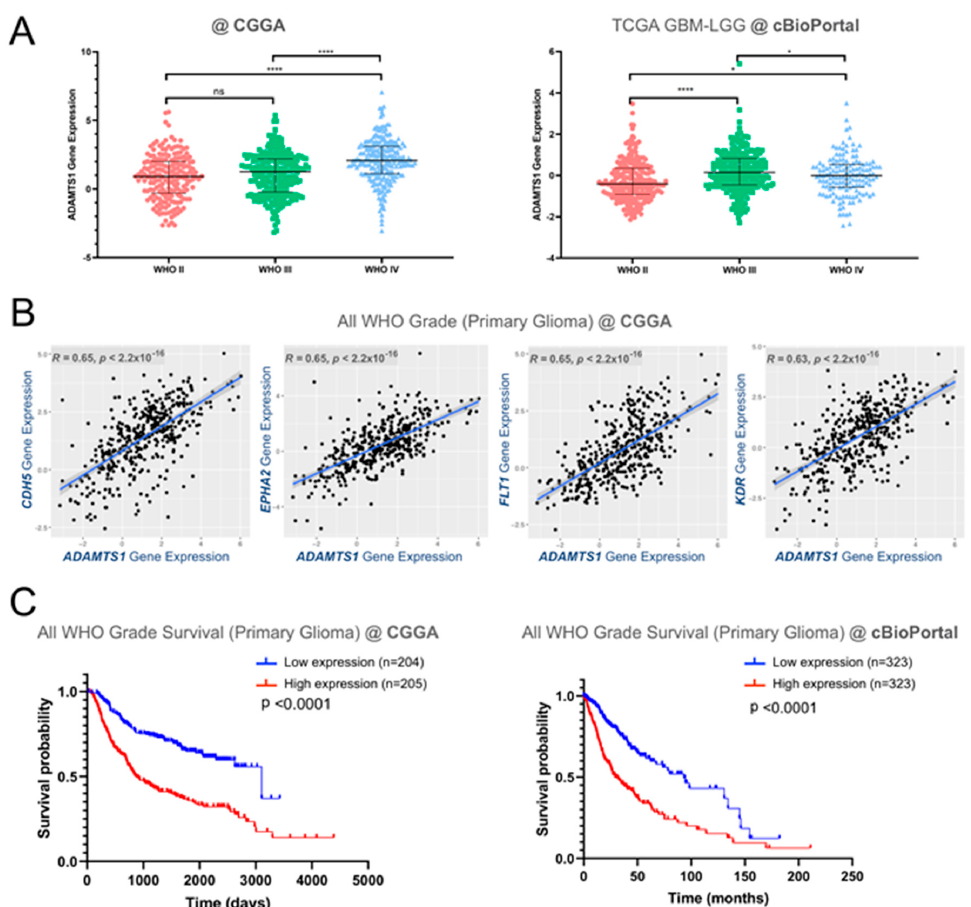
Figure 1. In silico analysis of ADAMTS1 and endothelial markers in glioma samples from Chinese Glioma Genome Atlas (CGGA) and The Cancer Genome Atlas (TCGA) glioblastoma multiforme- Low Grade Gliomas (GBM-LGG) projects. ( A ) Graph representing ADAMTS1 gene expression among different grades of glioma according to WHO classification, analyzing both CGGA and TCGA GBM-LGG datasets. TCGA data are analyzed with cBioPortal platform (****, p < 0.0001; *, p < 0.05 in unpaired t -test, using WHO II patients as control. Median and interquartile range are indicated for each group); ( B ) Scatter plots representing correlation analyses between gene expression levels of ADAMTS1 and endothelial-related genes CDH5, EPHA2, FLT1 and KDR ( R = Pearson correlation coefficient); ( C ) Kaplan–Meier survival curves for low and high gene expression levels of ADAMTS1 considering all glioma grades, in both CGGA and TCGA GBM-LGG